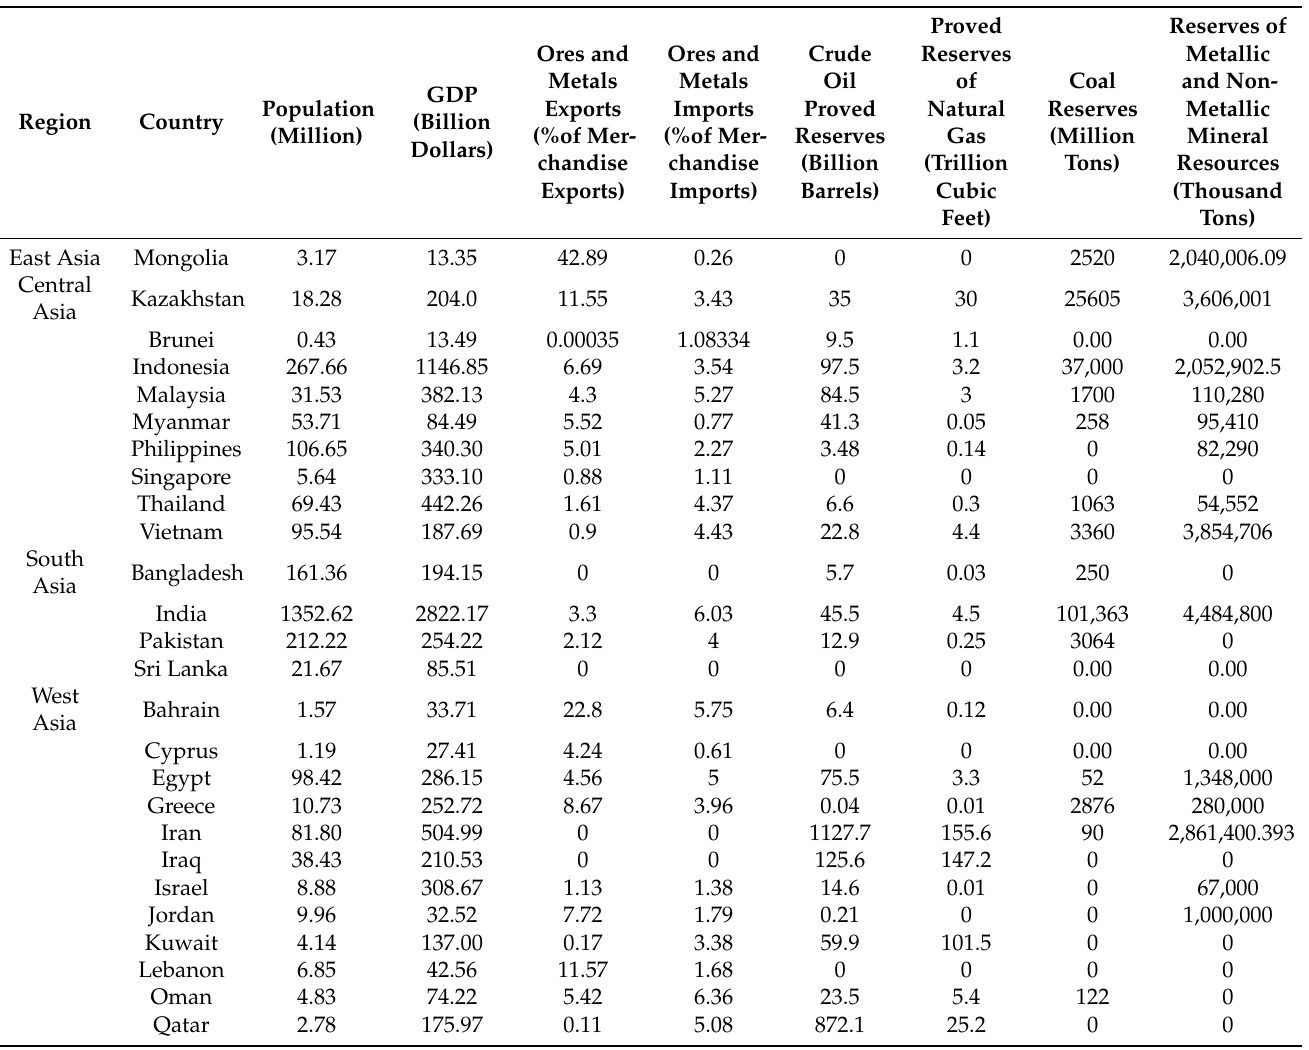
Table 1. Basic data of 50 nations along the